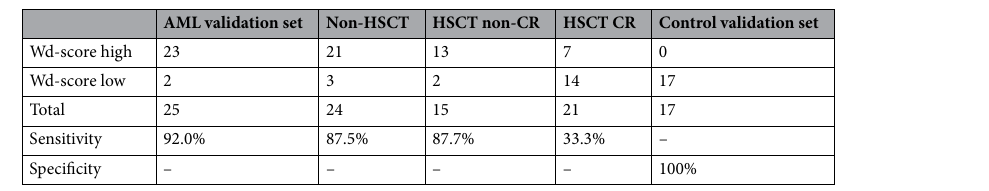
Table 1. Prediction using the 5hmC diagnostic model in AML patients. Non-HSCT did not receive hematopoietic stem cell transplantation, HSCT Non-CR received hematopoietic stem cell transplantation and not in complete remission, HSCT CR received hematopoietic stem cell transplantation and in complete